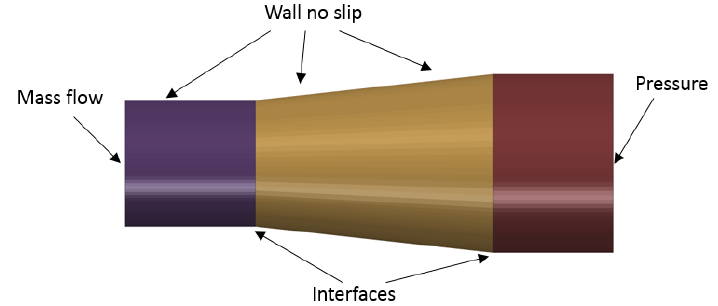
Figure 15. Boundary conditions in the matched grid model.